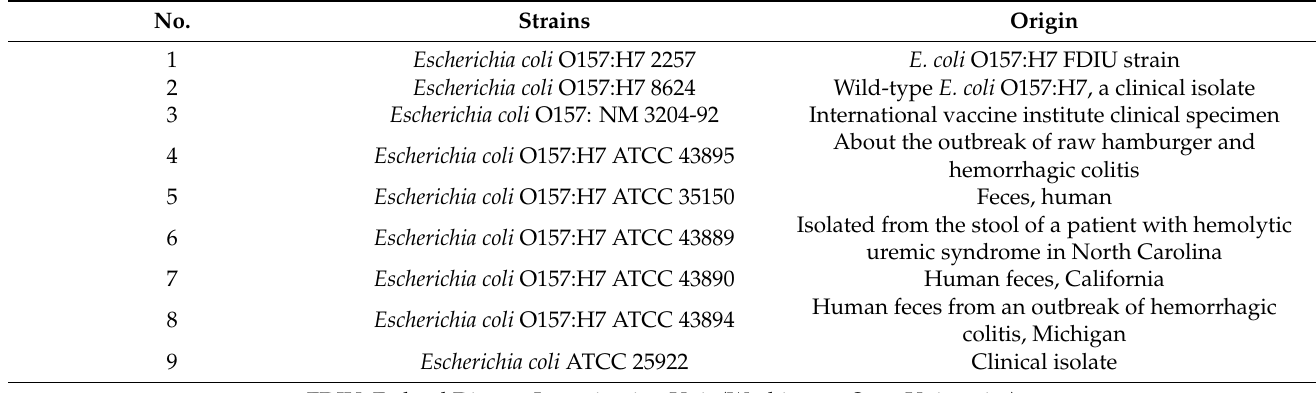
Table 3. E. coli O175:H7 strains used for antibacterial experiments.